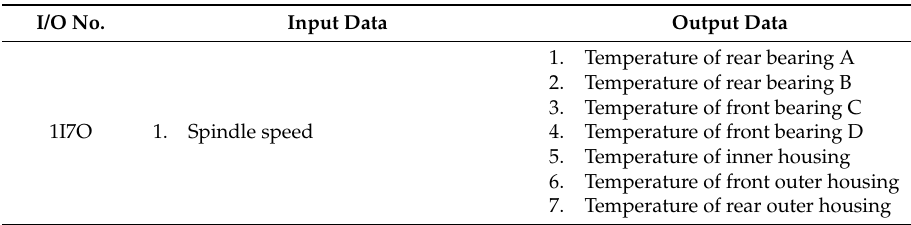
Table 6. The thermal-feature models and their input/output data.